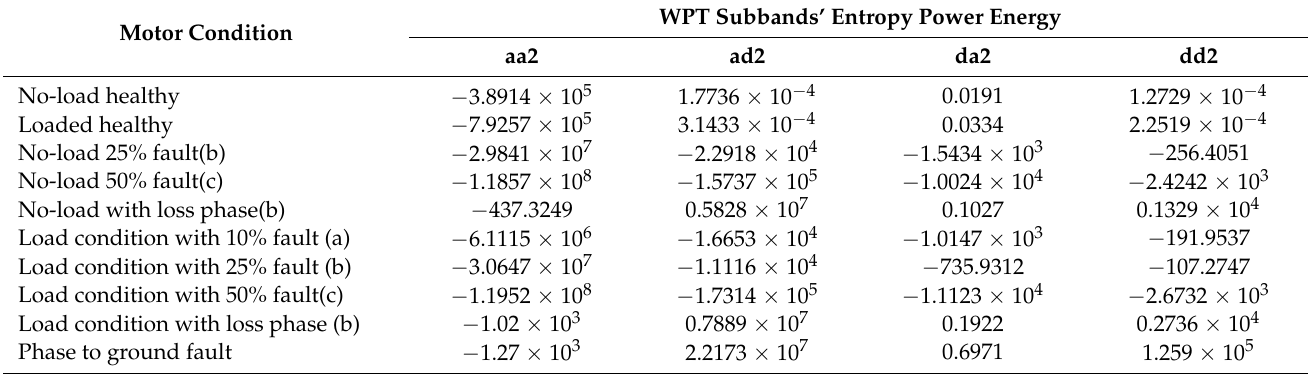
Table 7. Entropy power energy values of all four second level WPT subbands’ coefficients for different practical conditions of the induction motor.